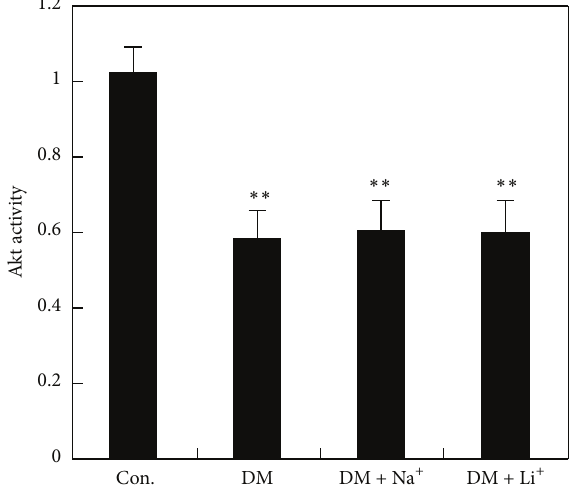
Figure 3: The activity of Akt. The activities of Akt in hippocampal extracts from rats injected with STZ, STZ plus NaCl, or STZ plus LiCl were determined by using specific peptide substrates. ∗∗ 𝑃 < 0.01 versus control